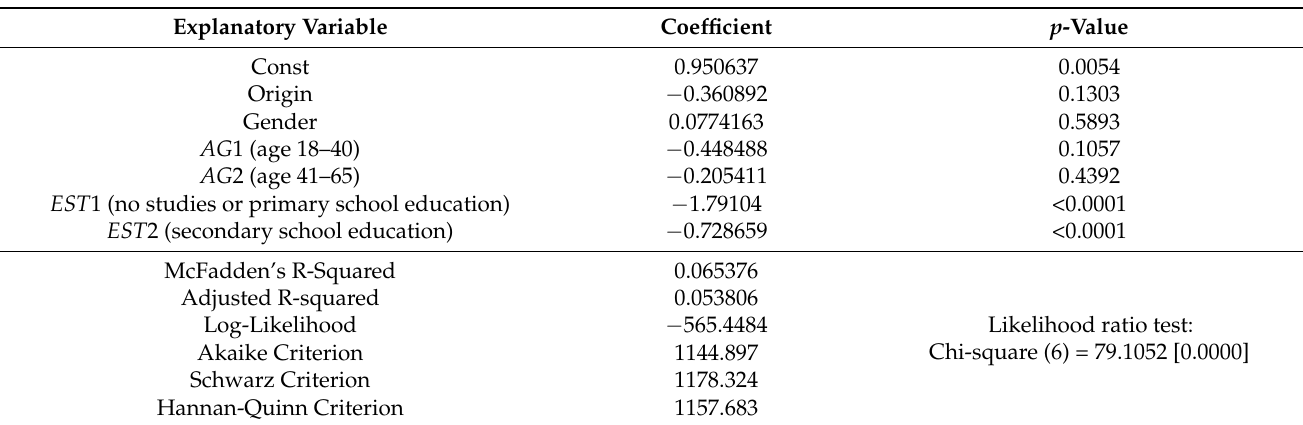
Table 1. Estimation of the restricted model.